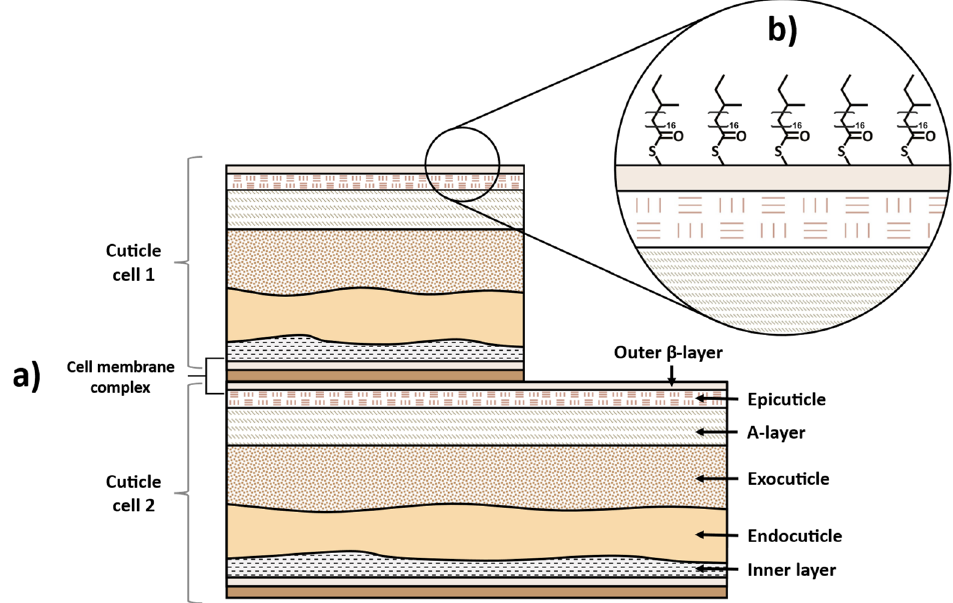
Figure 3. Schematic representation of ( a ) structure of hair cuticle cell and ( b ) lipid layer of 18 ‐ methyleicosanoic acid (18 ‐ MEA) covalently linked to the epicuticle outer surface via thioester linkages. Adapted from reference [13].